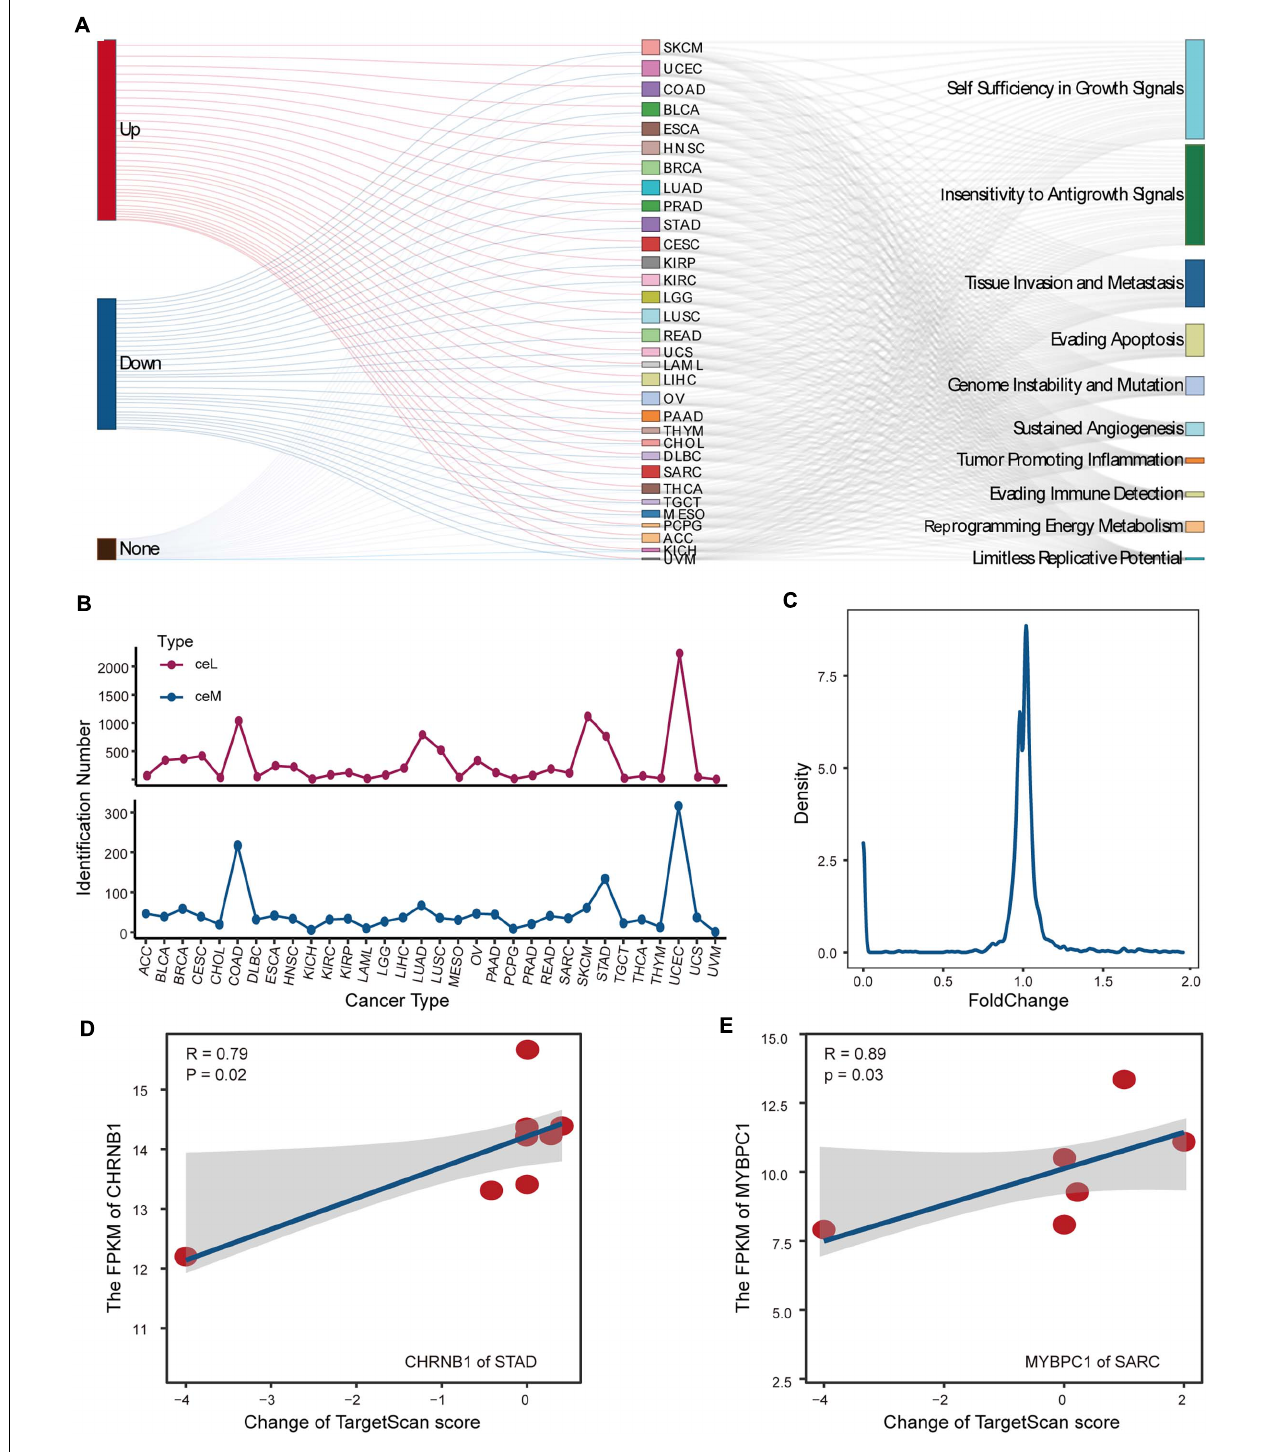
FIGURE 4 | Analysis and detection of LF-mutations. (A) Sankey diagram demonstrating the possible effects of putative LF-mutations on the corresponding ceM expression and the contribution of these ceMs to the 10 classical hallmark gene sets. (B) Numbers of ceM and ceL that passed the statistical test in pan-cancer. (C) Line plot illustrating the density distribution of fold change of all ceM that passed the statistical test in pan-cancer. (D) Relationship between expression of CHRNB1 in STAD and the corresponding lncRNA-miRNA target prediction scores shown by scatter plots with plotting of fitted curves. (E) Same as in (D) but for the expression of MYBPC1 in